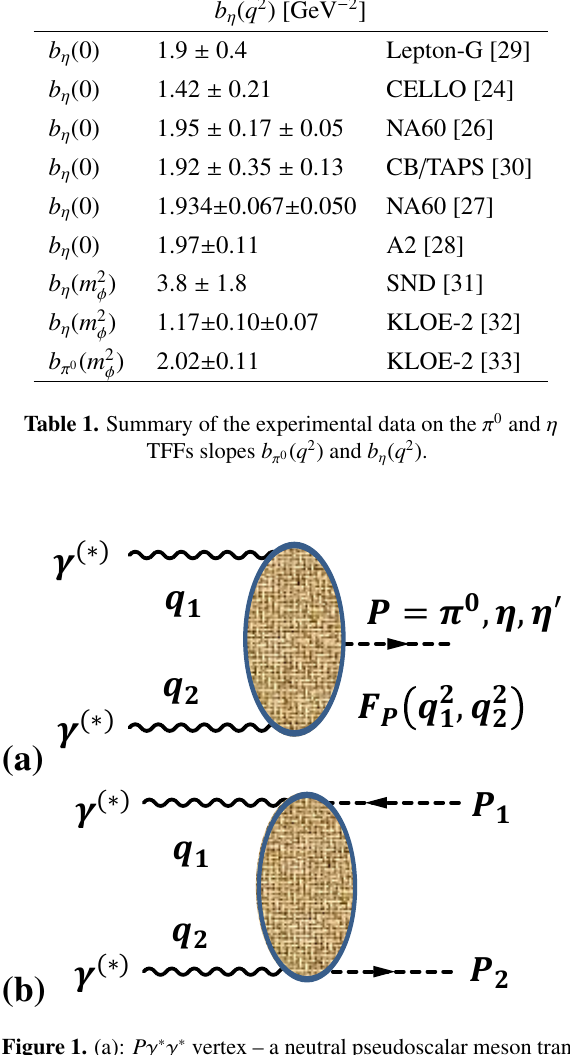
sition form factor; (b): P 1 P 2 γ ∗ γ ∗ vertex – two photon production of a pseudoscalar meson pair.